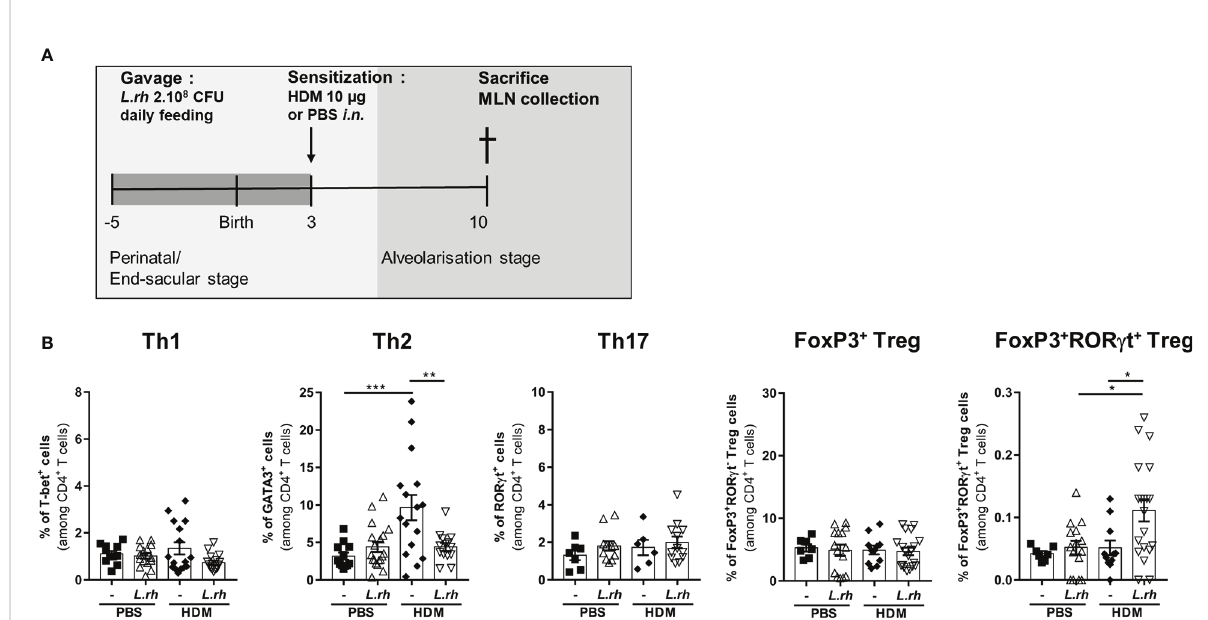
FIGURE 5 Maternal L.rhamnosus supplementation inhibits T cell polarization in the neonatal lung. (A) Neonates born from control (-) or L.rhamnosus - supplemented ( L.rh ) mothers were sensitized on PND3 with 10 µg HDM and sacri fi ced 1 week later. (B) Percentages of CD4 + T cells expressing the transcription factors associated with Th1 (T-bet), Th2 (GATA3), Th17 (Ror g T), conventional Treg (FoxP3) and ROR g t Treg (FoxP3 and ROR g t) cells were determined by FACS in the MLN of PND10 neonates. Results are a pool of 2 – 4 independent experiments and are shown as mean ± SEM. Statistical analysis was done using an ordinary one-way ANOVA test (Holm-Sidak ’ s multiple comparisons test) or a Kruskal-Wallis test (Dunn ’ s multiple comparisons test) (* = p <0.05; ** = p <0.01; *** = p